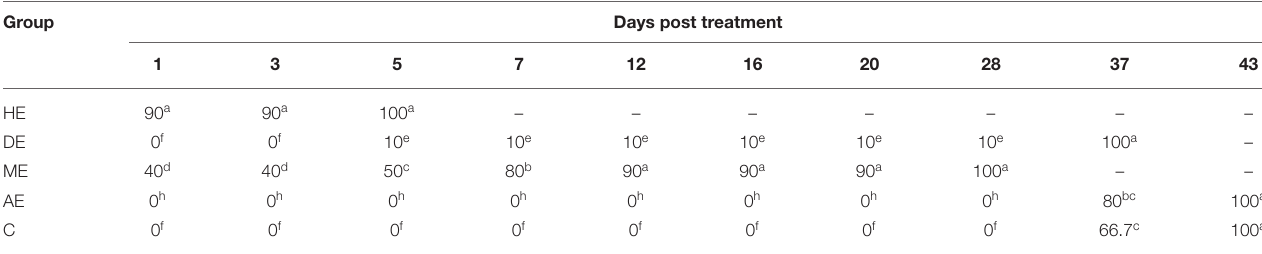
TABLE 2 | In vitro mortality rates of engorged Hyalomma dromedarii treated with 10% hexane, methanol, and dichloromethane extracts of neem seeds. Group Days post